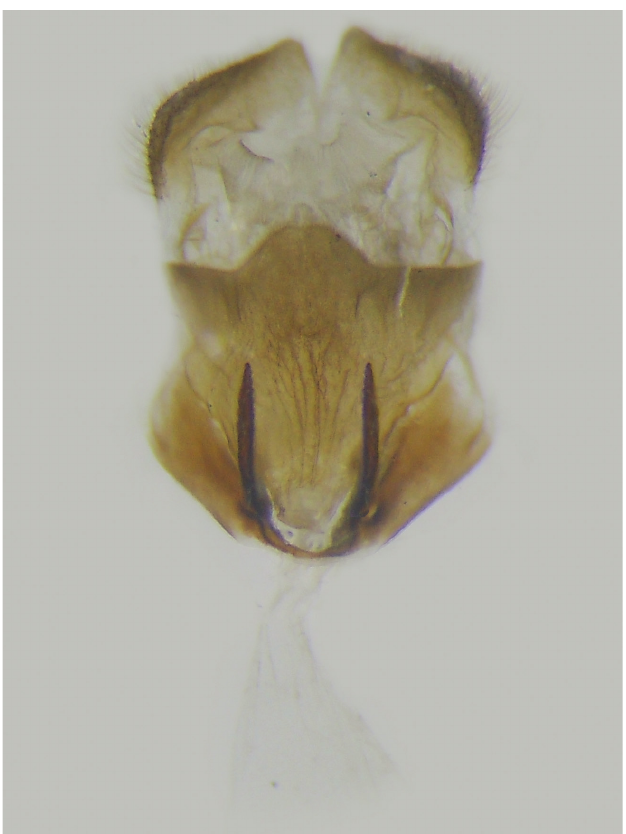
Figure 5. Female genitalia of Scobura masutaroi Sugiyama, 1996